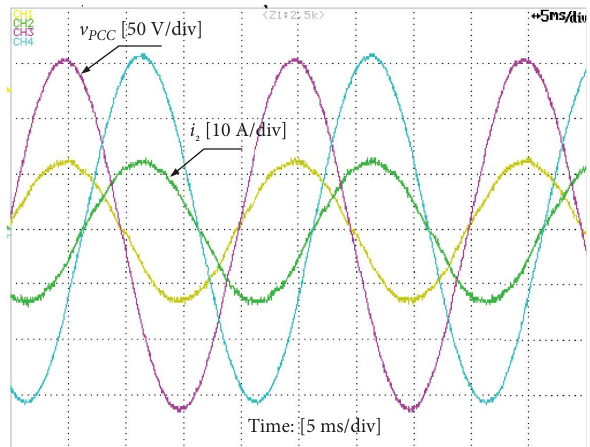
Time: [20 ms/div] Figure 16: Measured waveforms of PCC voltages and grid currents if the HPF feedback is disabled, when L g � 3.6mH and C g � 2 μ F.